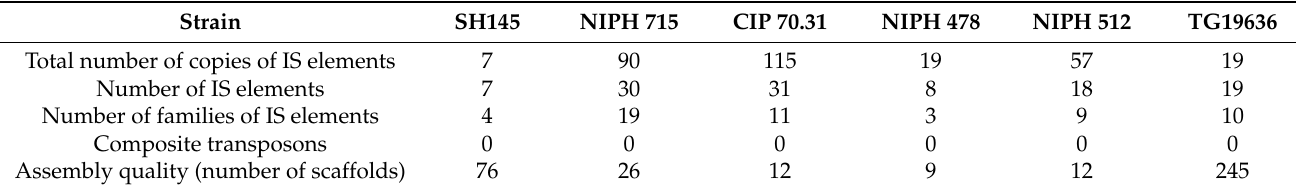
Table 7. Mobile elements in clinical strains of A. lwoffii